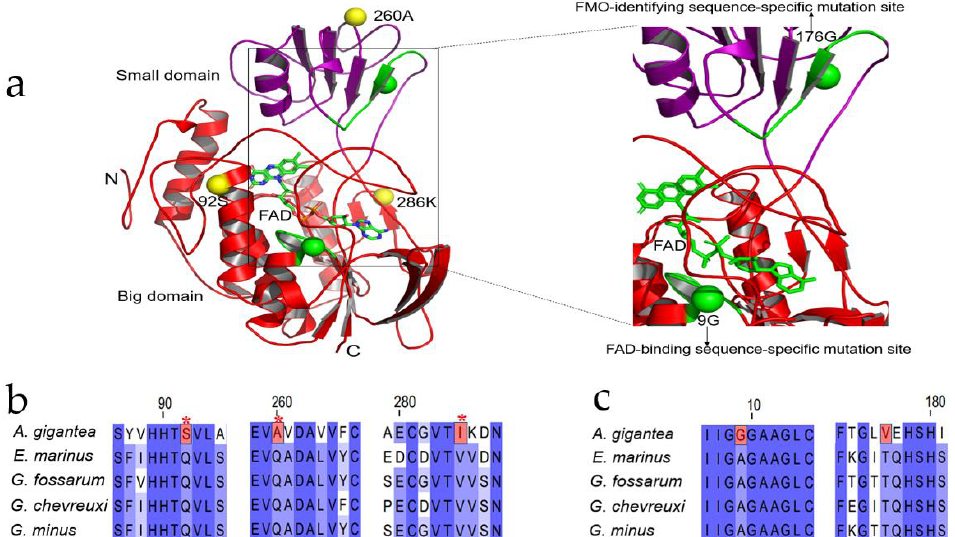
Figure 5. The three-dimensional crystal structure of FMO3 gene of A. gigantea and the positively selected site and specific mutation site of the FMO3 gene, ( a ) represents a three-dimensional view of the FMO3 protein, highlighting the locations of three positive selected sites (yellow spheres) and specific substitution sites on two conserved motifs (green spheres). Conserved motifs and the ligand FAD are also represented in green; ( b ) represents the location of positively selected sites in A. gigantea . Positively selected sites are represented in red, and * represents p < 0.05; ( c ) represents the locations of specific mutation sites that occur on a conserved motif in A. gigantea compared with the four amphipods in Gammaroidea, marked in red.